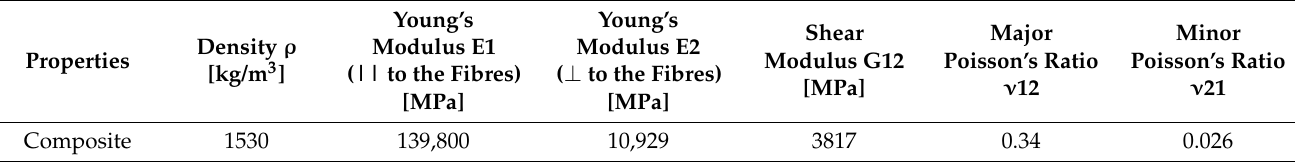
Table 2. Mechanical properties of composite material in direction of the lamina.